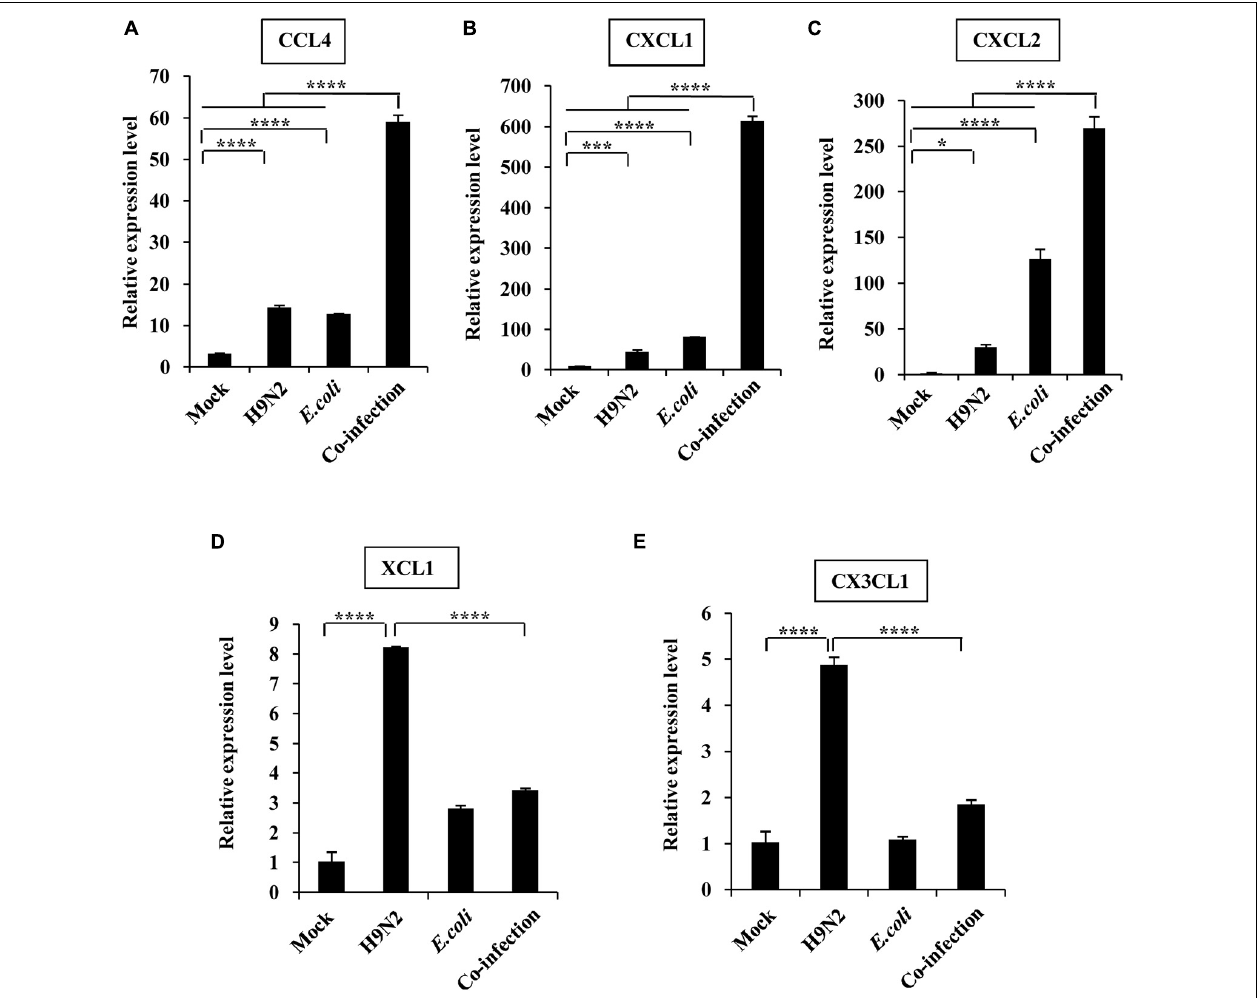
FIGURE 3 | Viral-bacterial co-infection induces aberrant expression of chemokines. Four groups of BALB/c mice were mock infected, or intranasally infected with single H9N2 AIV (1 × 10 4 PFU) and E. coli (1.5 × 10 7 CFU), or co-infected with H9N2 and E. coli for 48 h. Quantitative real-time PCR was used to measure the expression of CCL4 (A) , CXCL1 (B) , CXCL2 (C) , XCL1 (D) , and CX3CL1 (E) in mouse lungs. Data are presented as the mean ± SD of three independent experiments. * P < 0.05, *** P < 0.001, **** P <